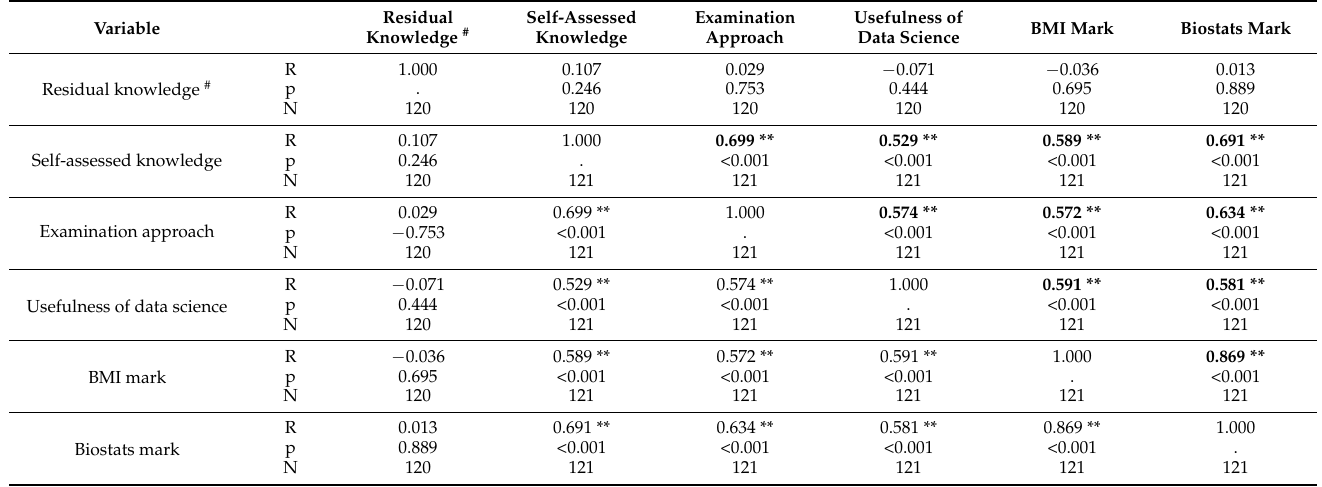
Significant R values over 0.5 are in bold. Notations: BMI, biomedical informatics; N, number of paired values in the correlation analysis; p, p -value for statistical significance; R, Spearman coefficient of correlation; #, one missing value for a male respondent; **, statistical significance, p < 0.01. Table 4. Associations between the EM lectures and practical activities and the two data science courses: two-by-two correlation matrix between the overall marks students gave to each course or